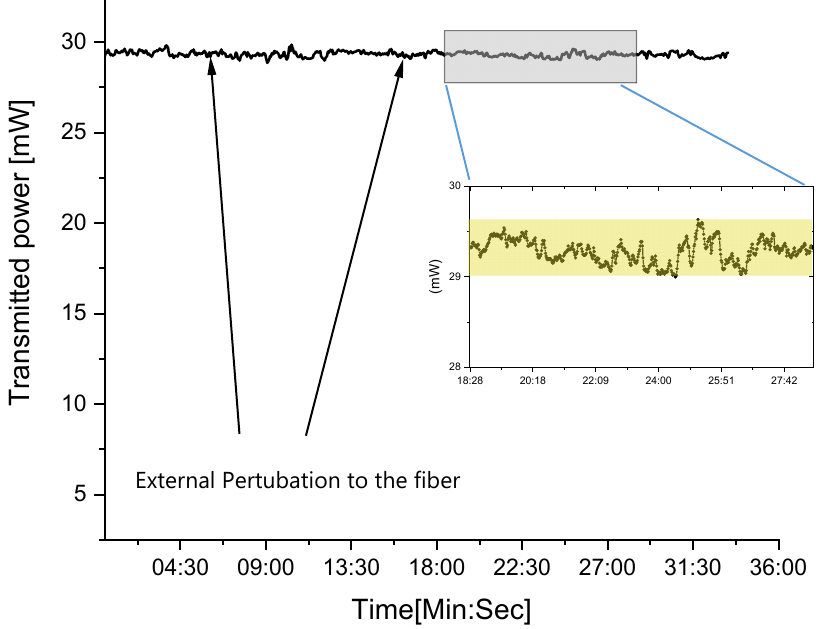
Figure 6. Long time measurement of the stability of the hollow-core fiber including the mechanical splices to the single mode fibers on each end. The inset shows a zoom in on a shorter time frame, showing fluctuations at the 2% level. For these measurements a broadband light source has been used that effectively eliminated the noise originating from modal